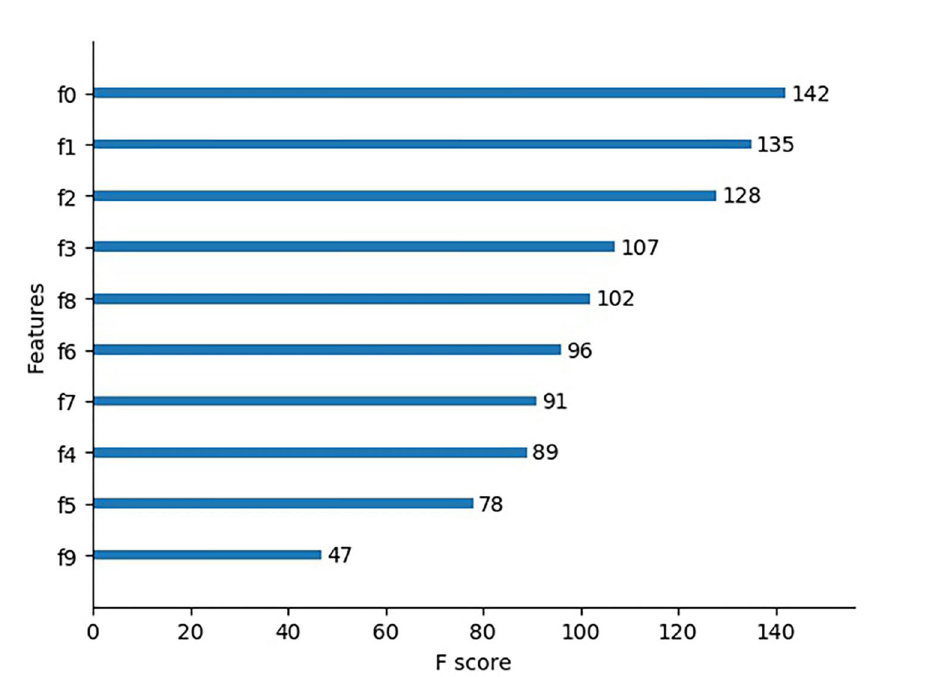
Figure 6. Ranking of feature importance scores after spectrum